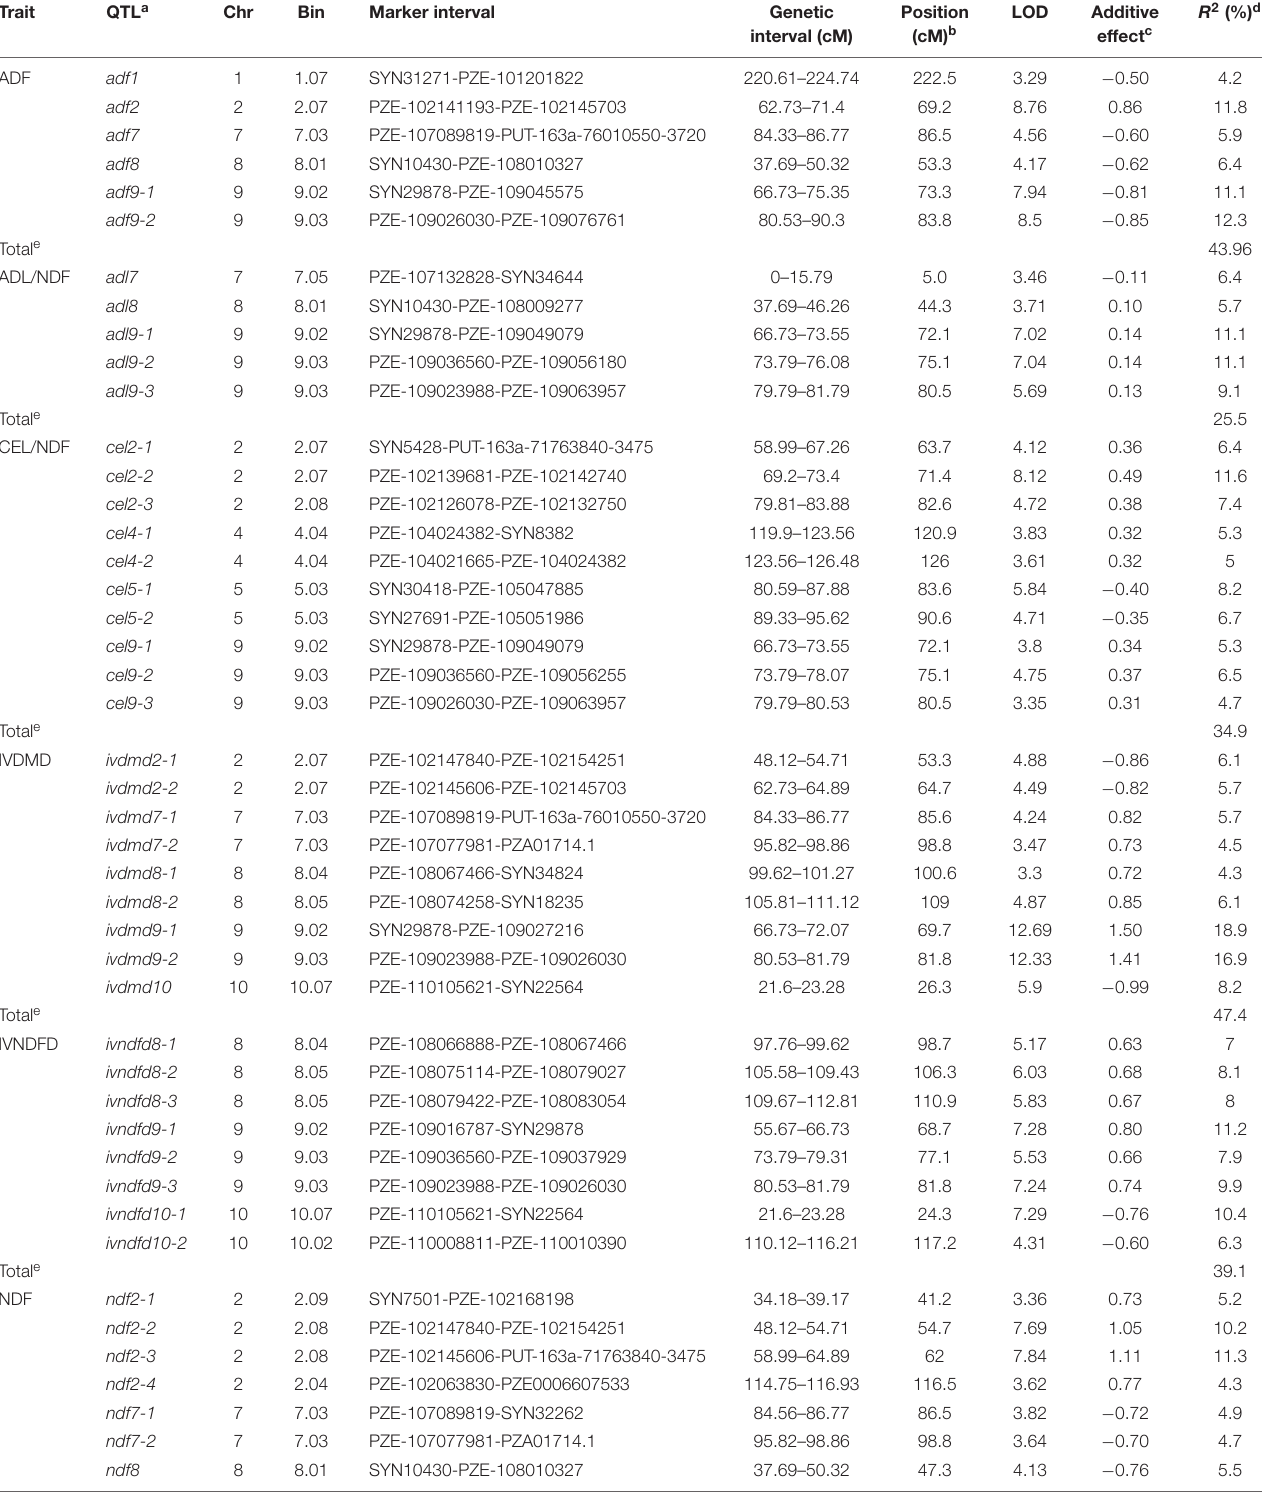
TABLE 2 | Summary of QTL for cell wall components and digestibility traits in the RIL